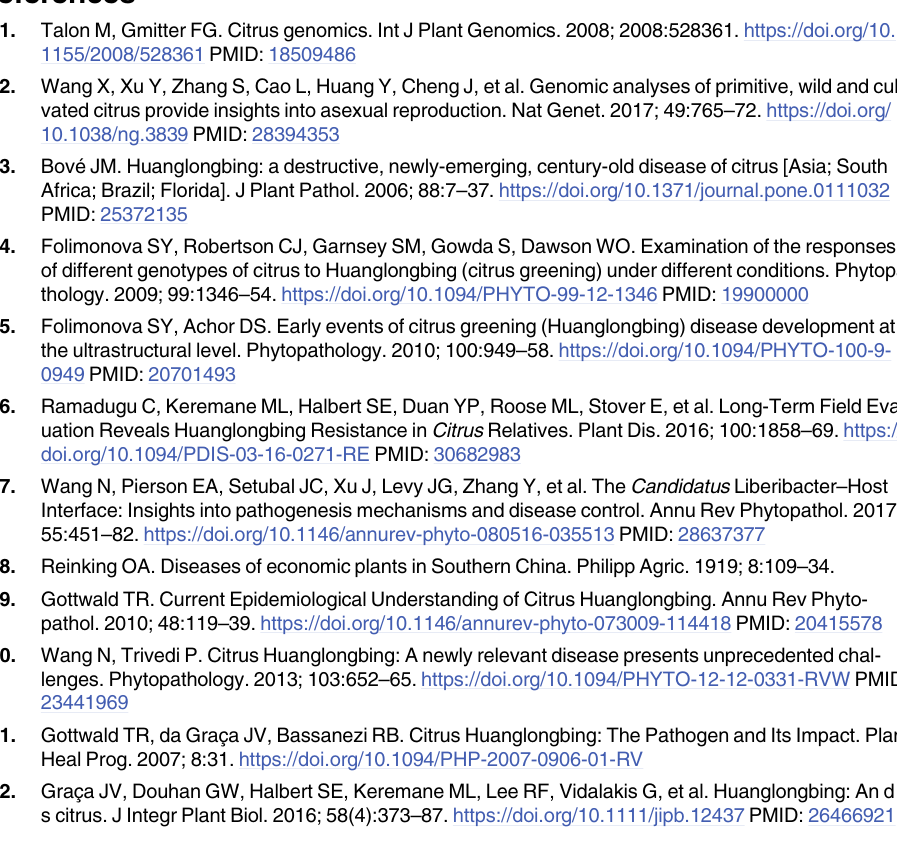
S1 Table. The information of unassembled genomes for the C Las.